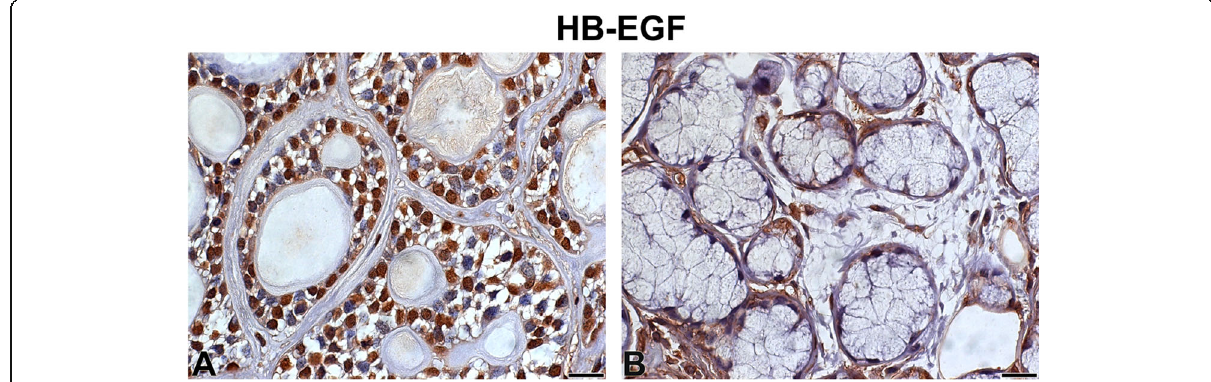
Fig. 4 HB-EGF Legend: Immunostaining of heparin-binding epidermal growth factor in adenoid cystic carcinoma ( a ) and normal-looking salivary gland ( b ). Immunoperoxidase. Scale bar: 20 μ m